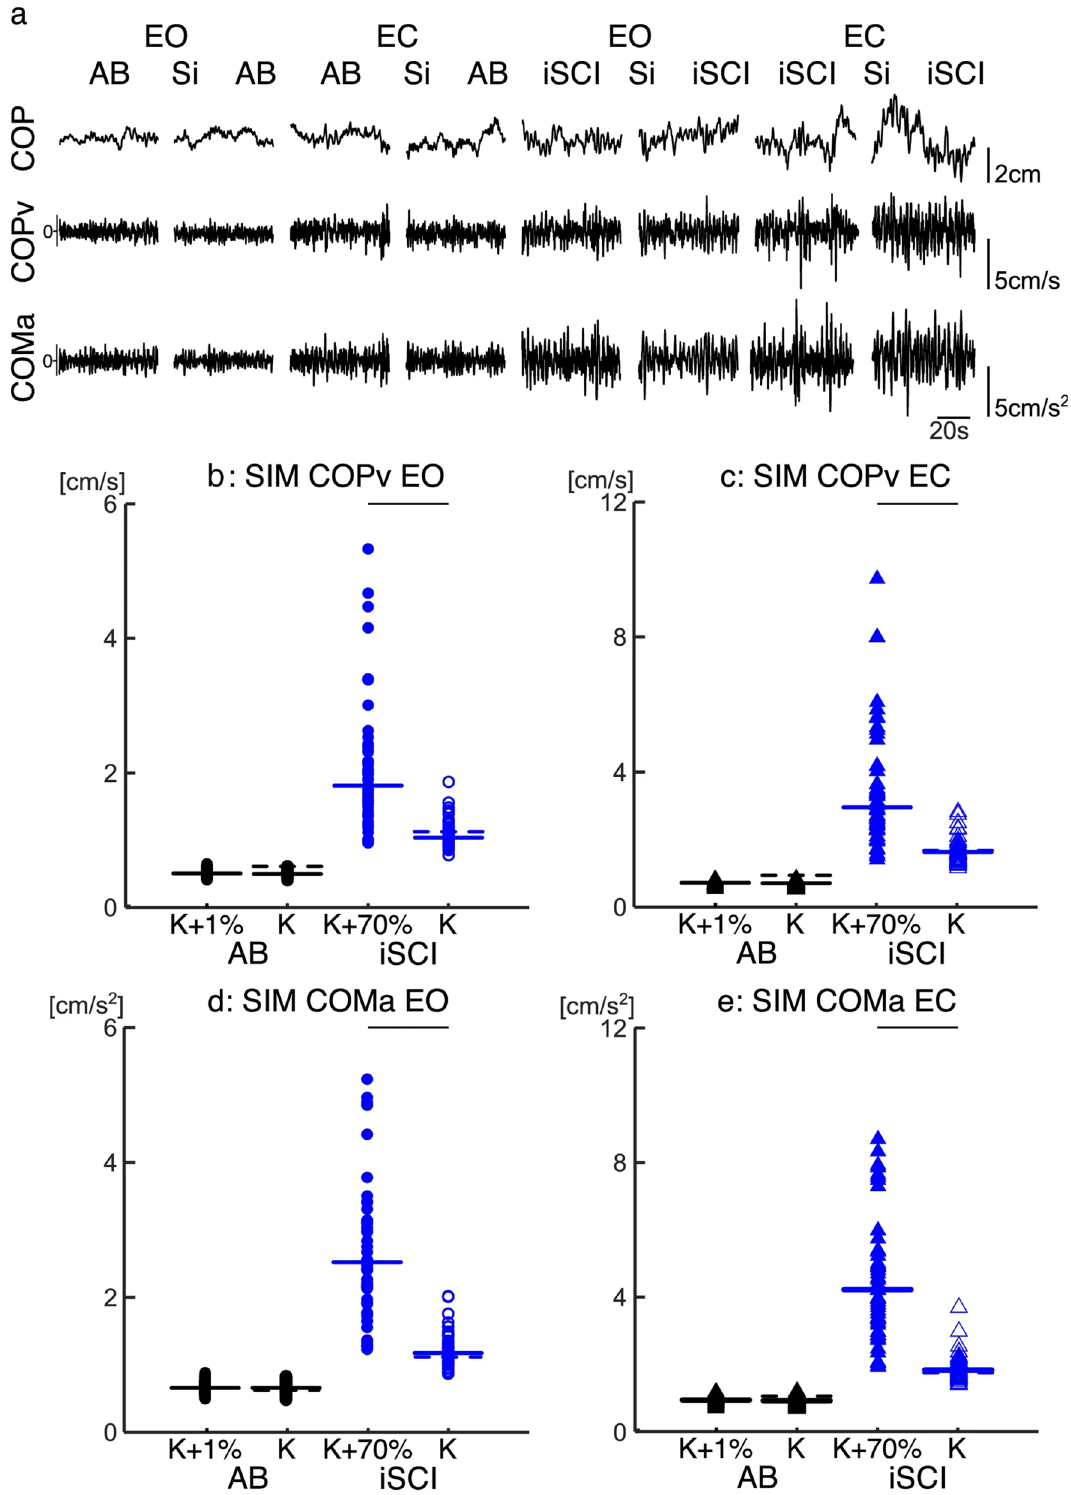
Figure 6. Example of the simulated postural sway (standard deviation of the COPv and COMa), and the comparison of an experimentally matched postural sway to postural sway due to an increased mechanical stiffness. ( a ) Representative 60 s traces for the experimental (AB/iSCI) and simulated (Sim-AB/Sim-iSCI) COP, COPv and COMa in both EO and EC conditions. ( b ) Distribution of the fluctuation of the COPv in the EO condition. ( b ) Distribution of the fluctuation of the COPv in the EC condition. ( c ) Distribution of the fluctuation of the COMa in the EO condition. ( d ) Distribution of the COMa in the EC condition. Simulation data presented for the Sim-AB (black, N = 137) and Sim-iSCI (blue, N = 55) groups in both EO (circles) and EC (triangles) conditions for periods of co-contraction (K + %—filled shapes) and no–co-contraction (K—empty shapes). Thick horizontal lines represent the group median, horizontal dashed lines represent the target experimental postural sway data used to determine the gains sensory and internal noise for the simulations. Individual data are plotted. Thin horizontal lines above the plots represent significant differences (p <